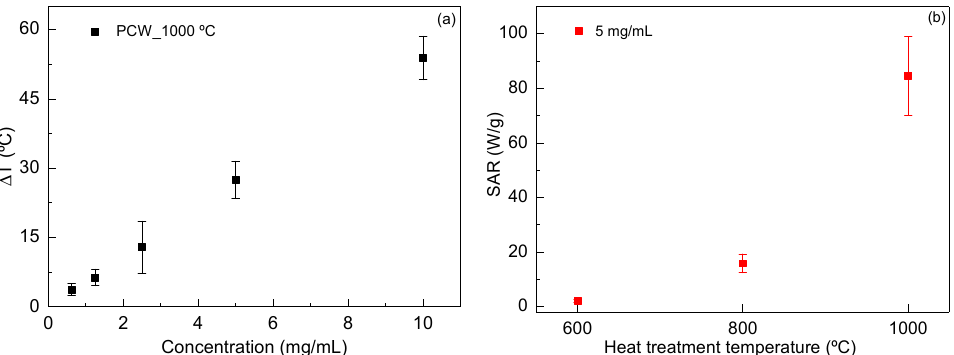
Figure 10. ( a ) Temperature increase generated by LiFe 5 O 8 ferrite after heat treatment at 1000 °C. ( b ) Specific absorption rate of LiFe 5 O 8 ferrites after heat treatment at different temperatures from 600 °C up to 1000 °C using a concentration of 5 mg/mL in ultrapure water.